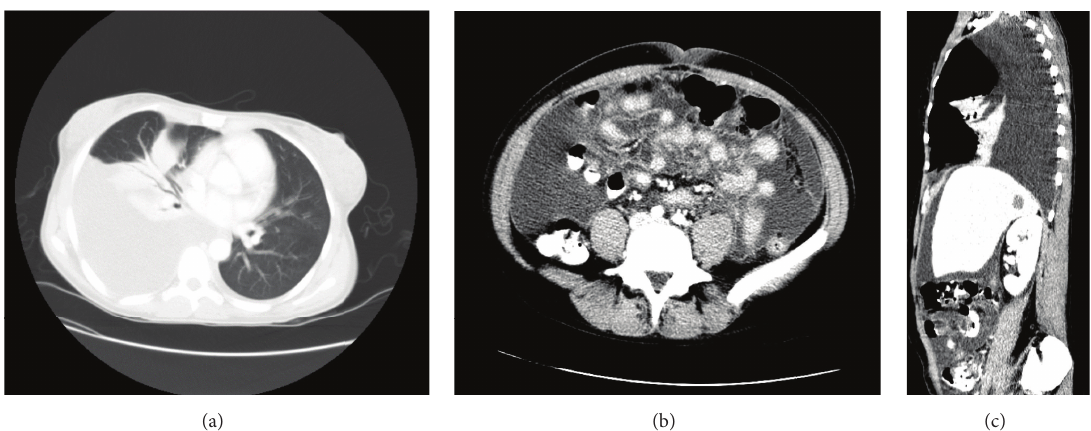
Figure 1: Computerized tomography scan of the abdomen and pelvis in sagittal and transverse planes showing large right-sided pleural effusion and massive abdominal ascites.